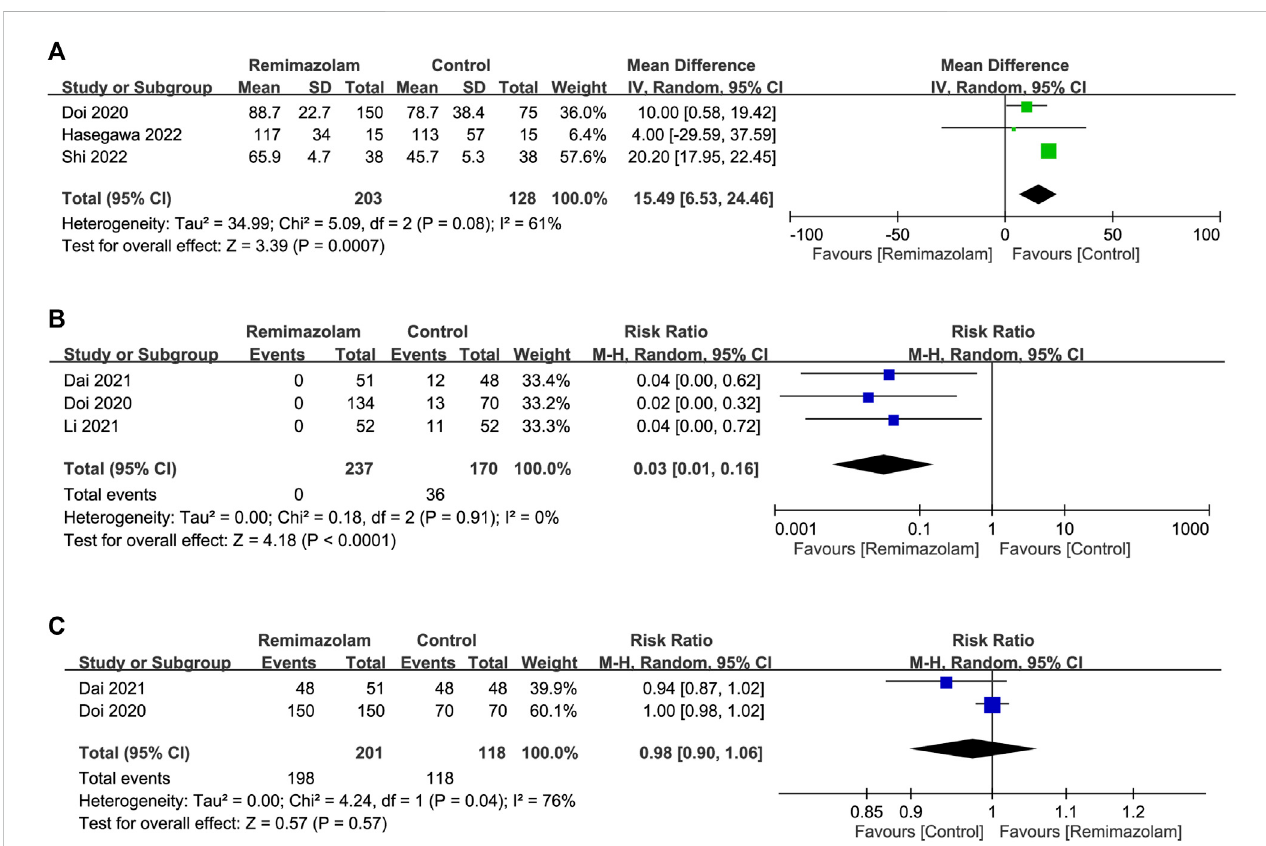
FIGURE 5 Forest plot comparing (A) time to loss of consciousness; (B) risk of injection pain and (C) ef fi cacy of anesthetic induction between remimazolam and control groups. CI, con fi dence interval; IV, inverse variance; M-H, Mantel-Haenszel.